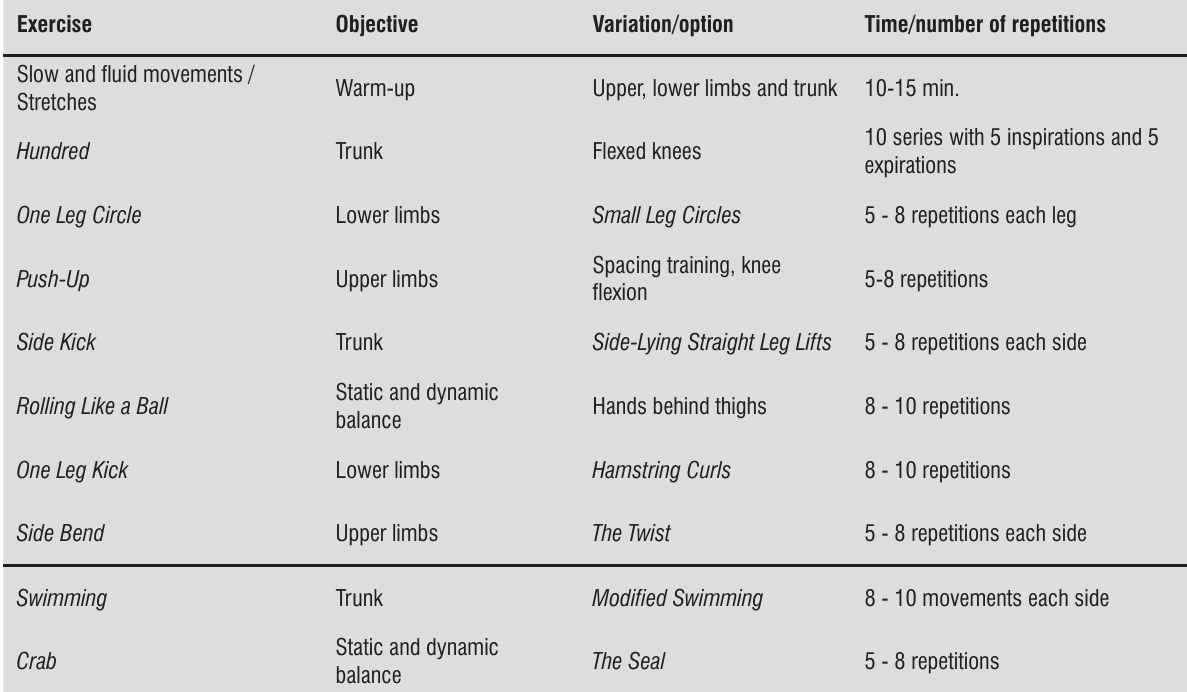
Figure 1 - Intervention study